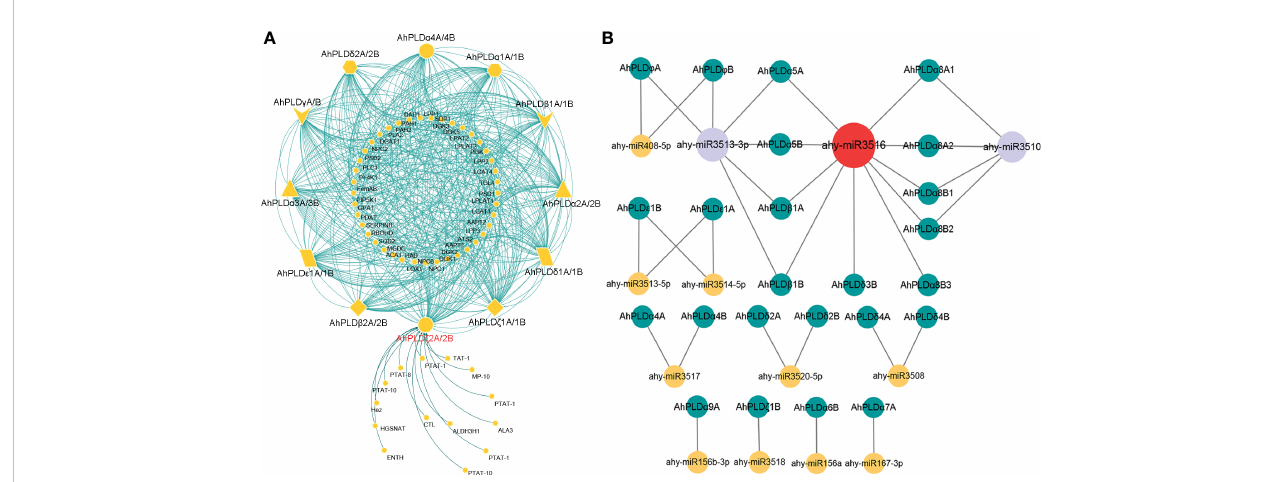
FIGURE 7 Interactions and regulations of peanut PLD genes with other proteins and miRNAs. (A) Protein-protein interaction network of peanut PLD proteins with other proteins. The yellow geometric fi gures represent peanut PLD proteins. The little yellow dots represent other proteins that interact with AhPLDs. The interaction relationships are shown by green lines. (B) Regulatory network of putative miRNAs and their targeted AhPLDs . The yellow, purple and red circles represented miRNAs. The green circles represent targeted AhPLDs . The putative regulatory relationships between miRNAs and their targeted AhPLDs are shown in grey